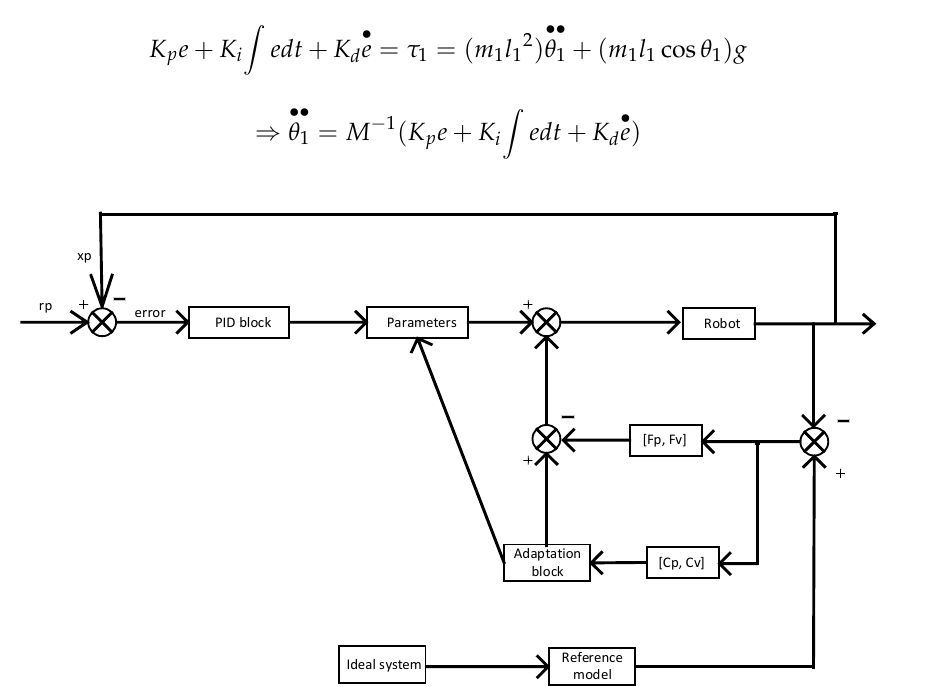
Actuators 2018 , 7 , x FOR PEER REVIEW Figure 8. Control system for 1-DOF manipulator. Figure 8. Control system for 1-DOF manipulator.